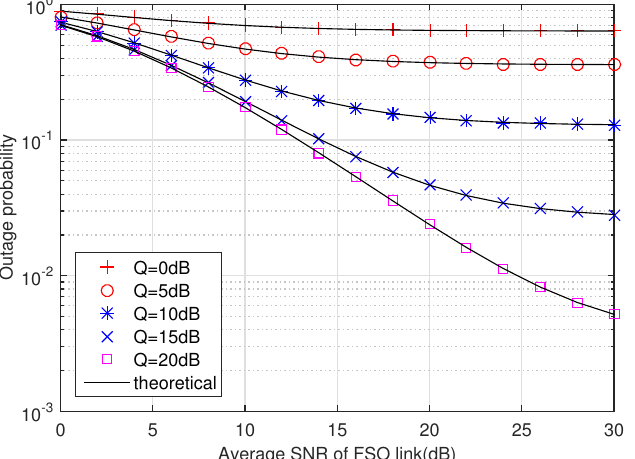
Figure 4. Outage probability under different interference threshold levels with heterodyne